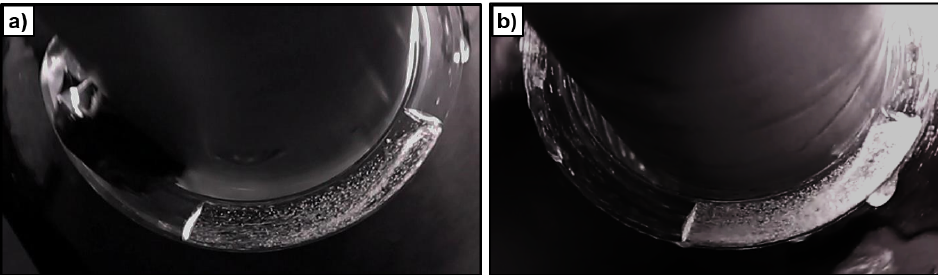
and ( b ) solid content w solid = 5.1 g Ala · 100 g − 1 Sol